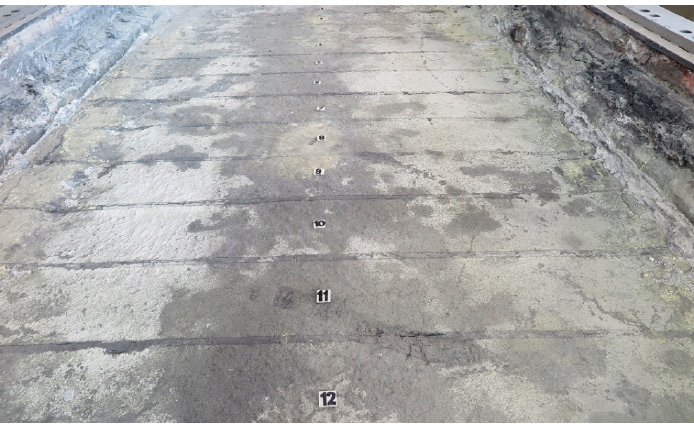
Figure 14. Cleaned DX pot cavity with CleO 2 paste at 369 days.